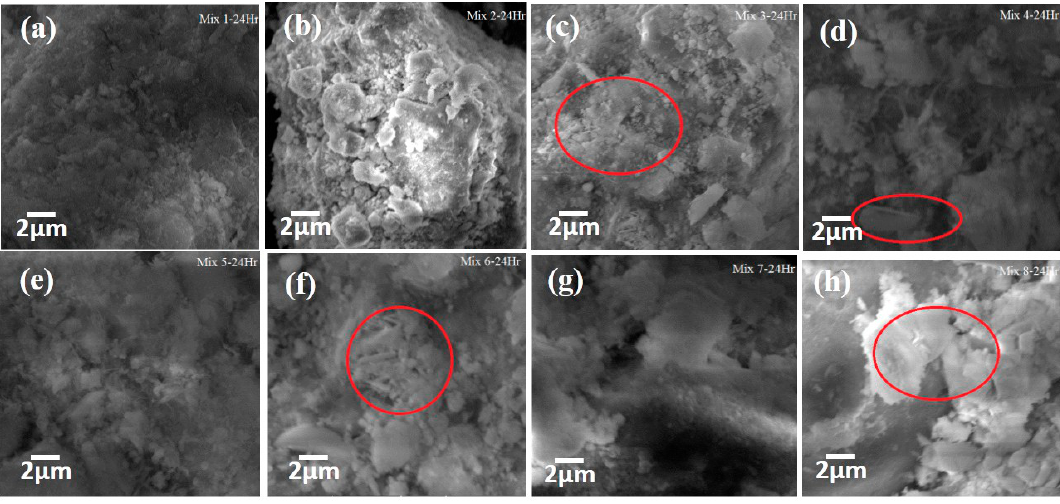
Figure 7. ( a – h ) SEM images represent the morphologies of Mixes 1 to 8 of hydration after the 7th day.